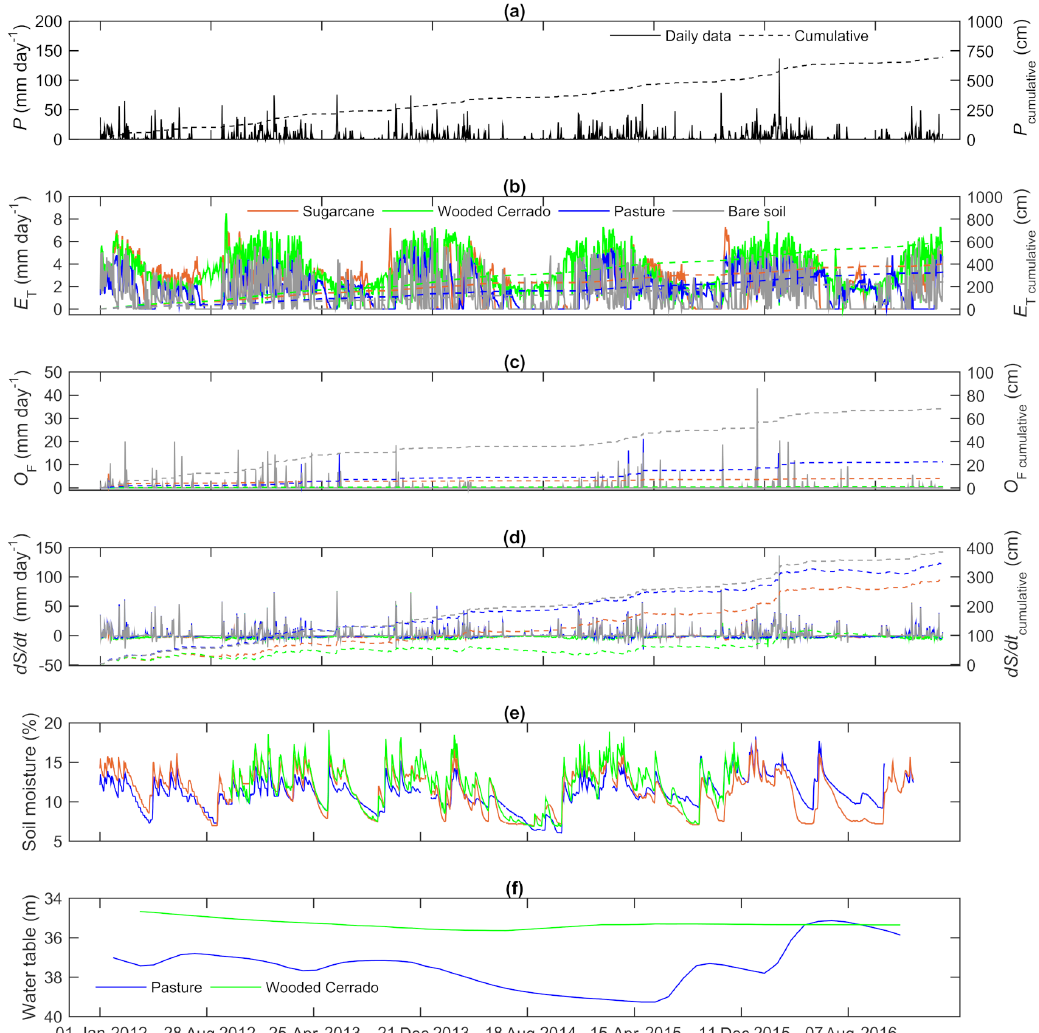
Figure 3. Water balance components for different LCLU types, namely rainfall, P (a) ; evapotranspiration, E T (b) ; surface runoff, O F (c) ; and water balance residual, d S/ d t (d) . Right axes present the cumulative sum of the variables represented by graphs (a) , (b) , (c) and (d) . Soil moisture in the first meter of soil (e) for pasture, sugarcane and wooded Cerrado; water table (f) depth of the monitoring wells located in site 1 (pasture) and site 2 (wooded